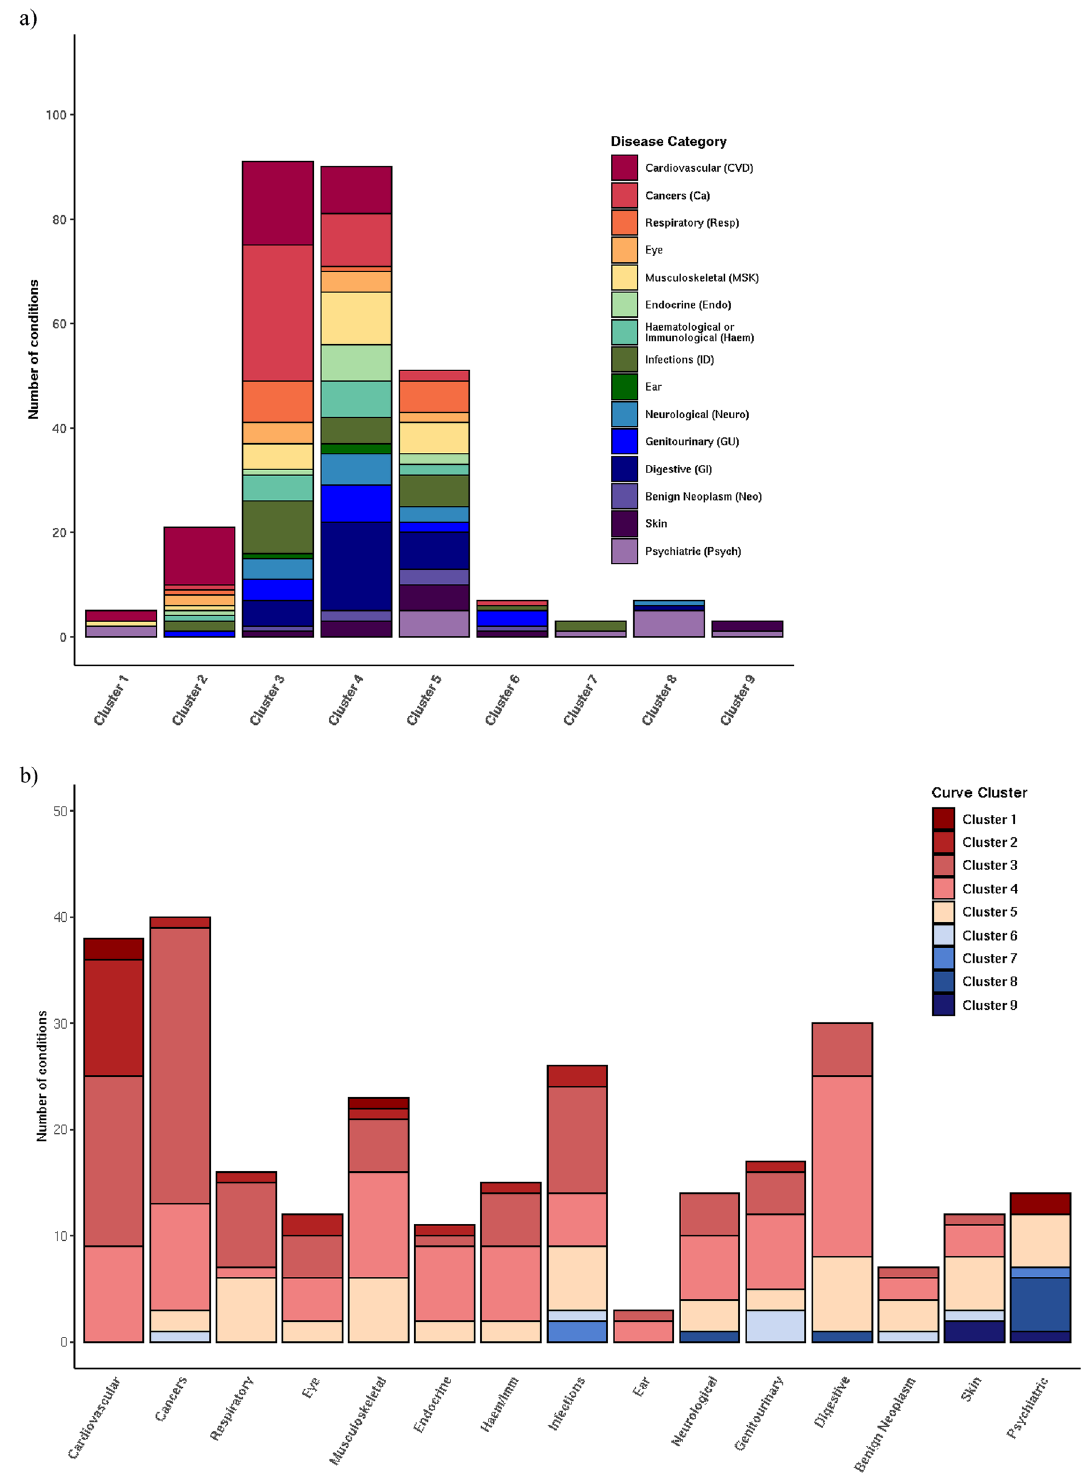
Figure 3. The relationship between disease category and age curve cluster for 278 diseases: ( a ) Diseases in each age cluster by disease category. ( b ) Diseases in each disease category by age curve cluster. The number of diseases in each disease category and age curve cluster is shown in Table